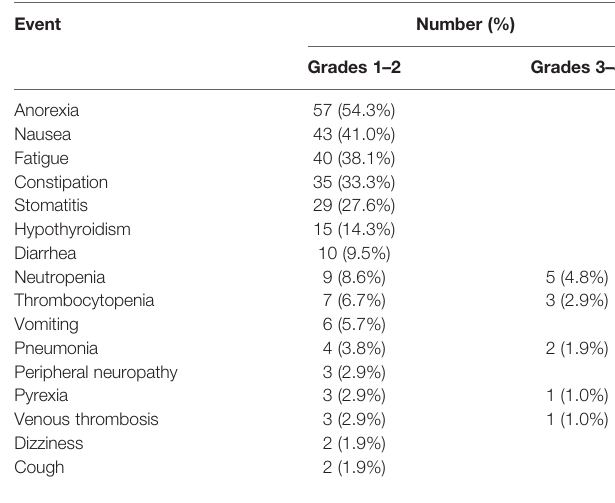
TABLE 4 | Adverse events in the 105 patients.